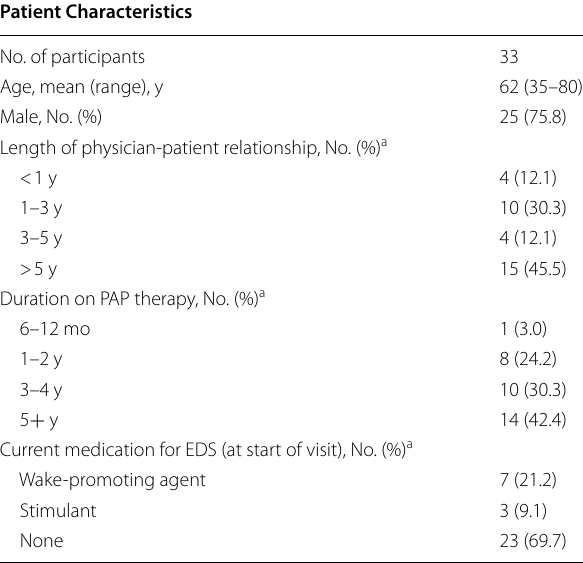
Table 2 Characteristics of participating